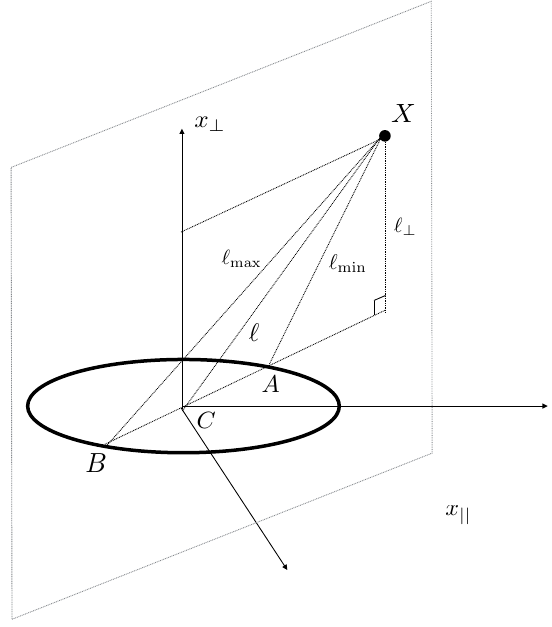
Figure 2 . A generic con(cid:12)guration of a circular defect and bulk-local operator. Additional insertion of defect-local